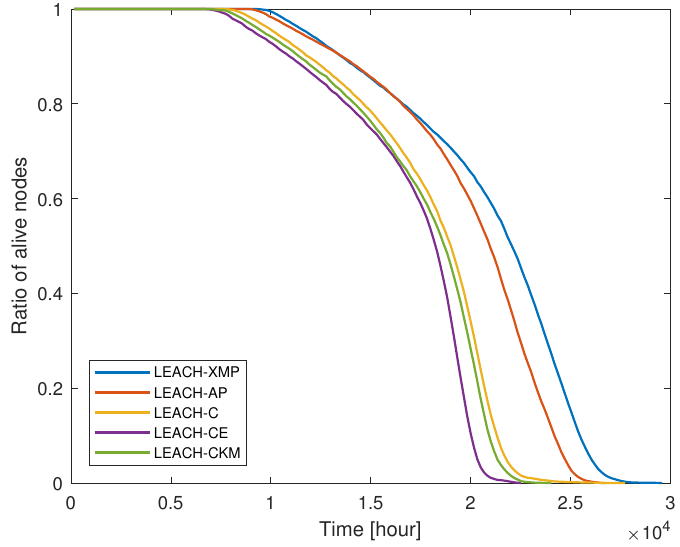
Figure 4. Ratio of live nodes versus